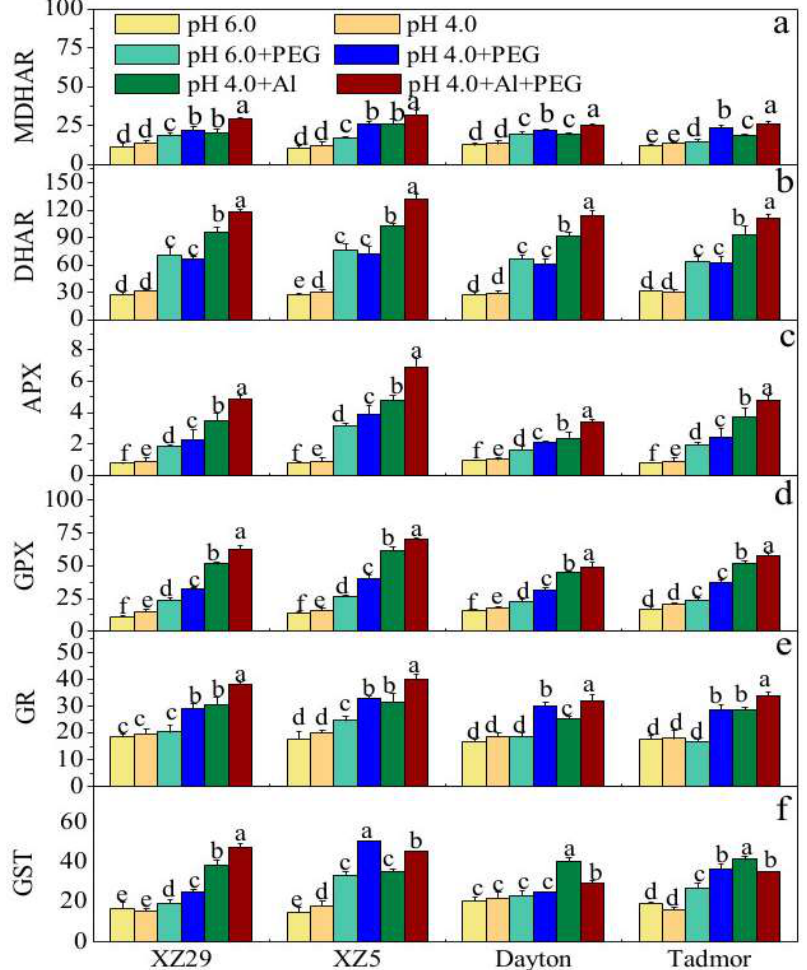
Figure 3. Effects of pH, PEG, Al, and pH 4.0+Al+PEG stresses on ( a ) monodehydroascorbate reductase (MDHAR), ( b ) dehydroascorbate reductase (DHAR), ( c ) ascorbate peroxidase (APX), ( d ) glutathione peroxidase (GPX), ( e ) glutathione reductase (GR), and ( f ) GSH S-transferase (GST) of four barley genotypes seven days after treatment. Error bars represent SD values ( n = 6). Different letters indicate significant differences among the treatments within each genotype according to Duncan’s multiple range test with p < 0.05.